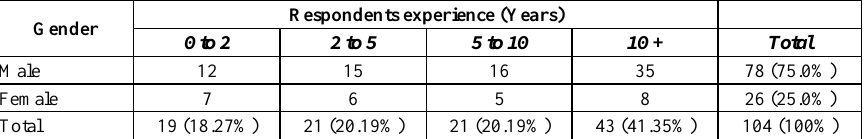
Table 4. Survey background